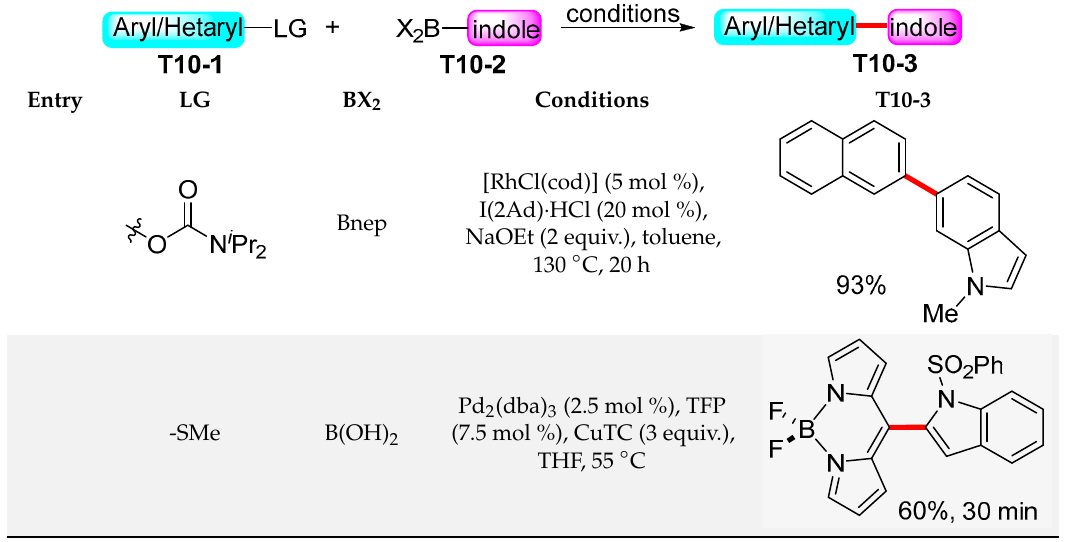
Table 10. Palladium- and rhodium-catalyzed arylation of indolylboronic acids.